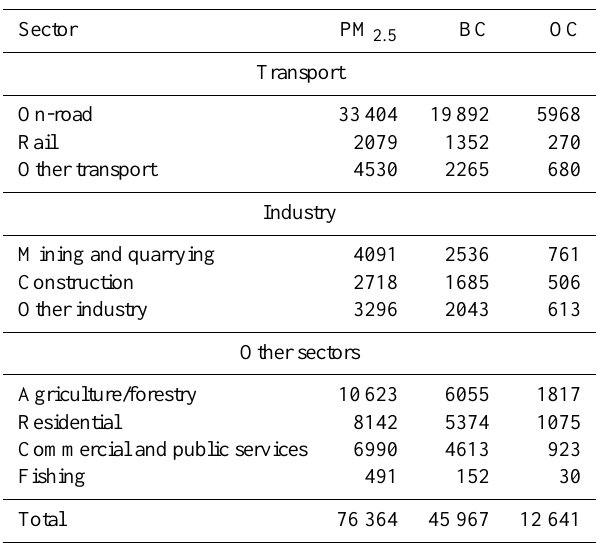
represent an important opportunity for reducing emissions,